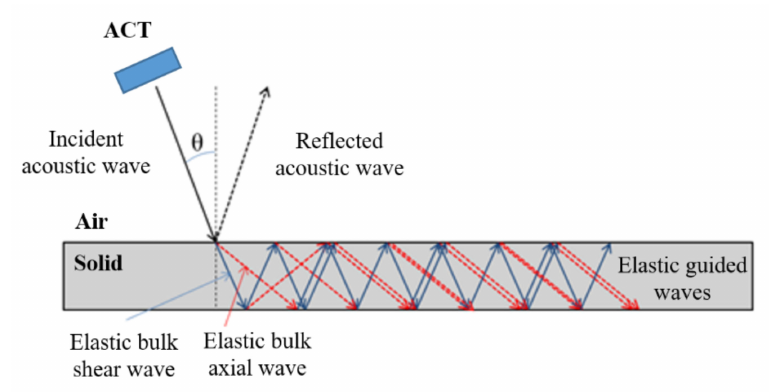
Figure 1. The conversion scheme of acoustic waves (AW) into elastic